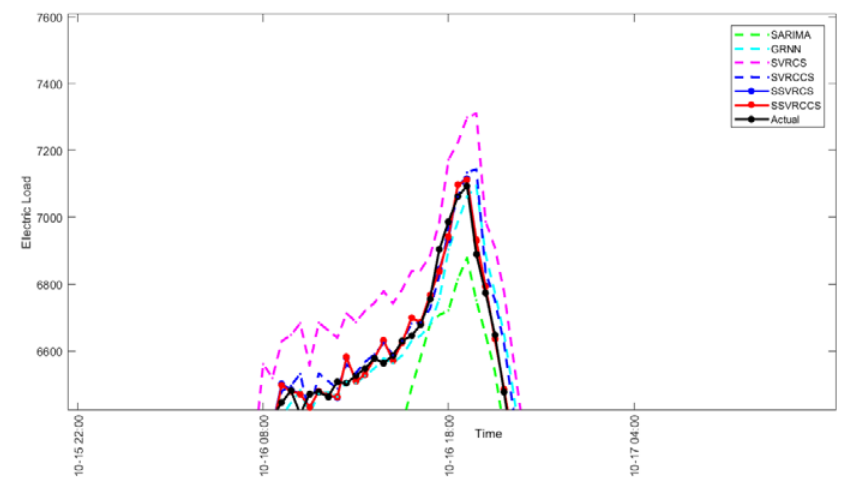
Figure 8. The enlargement comparison of Peak 4 from the compared models for Example 1.